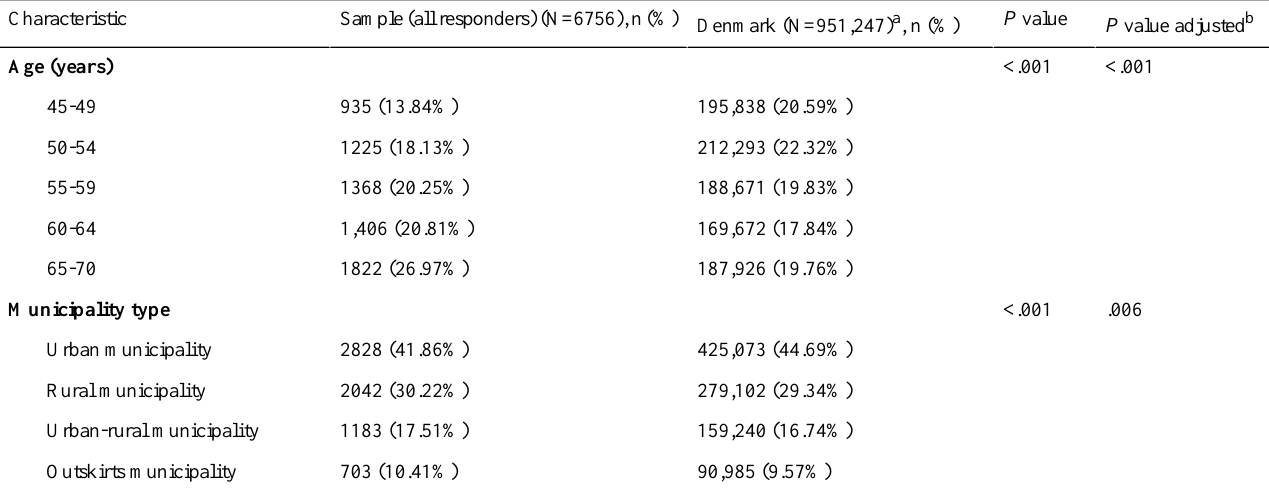
Table 5. Comparison of responders with the entire Danish population of men.